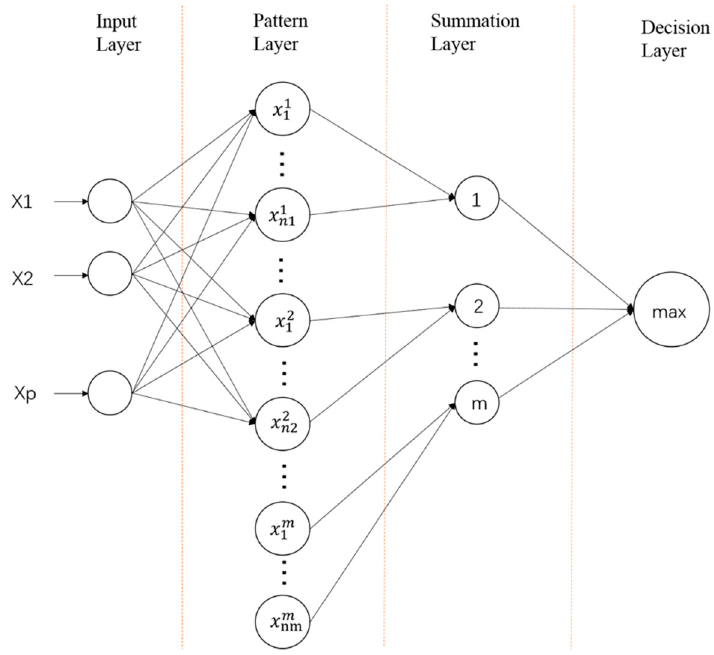
Figure 7. PNN structure.